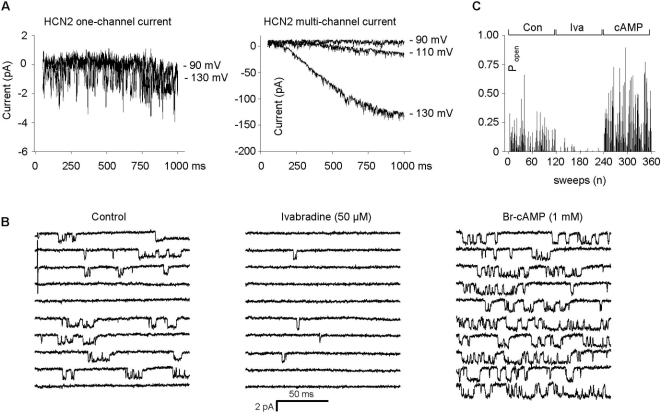
Electrophysiological and pharmacological properties of IHCN/If on single-channel level from inside-out recordings.(A) Representative HCN2 single-channel currents (sampling frequency: 5 kHz, corner frequency: 1 kHz) of inside-out recordings from one- and multi-channel (n∼50 channels) patches at different test-potentials (−90 to −130 mV). (B) Pharmacological characteristics of HCN2 single-channels (test potential: −90 mV, holding potential: −35 mV). Ivabradine (50 µM) blocks HCN2 single-channel current during repetitive activation/deactivation steps (−90 mV, 150 ms/+10 mV, 600 ms). The observations that ivabradine significantly reduced the open probability (25.8±7.07% vs.6.08±3.45%, n = 4, p<0.05), the mean open time (1.03±0.12 ms vs. 0.61±0.16 ms, n = 4, p<0.05) and the availability (75.9±10.1% vs. 25.3±6.98%, n = 4, p<0.05) suggests an open-channel blockade by a fast and a slow gating mechanism. cAMP induced an increase of the channel activity (for data, see text). The data were sampled at 10 kHz and filtered at 2 kHz. (C) Effect of ivabradine (Iva) and cAMP on single-channel activity. Open probability (Popen) decreased after ivabradine (50 µM) and increased after cAMP (1 mM) application, respectively. Data recorded as in Figure 3B.